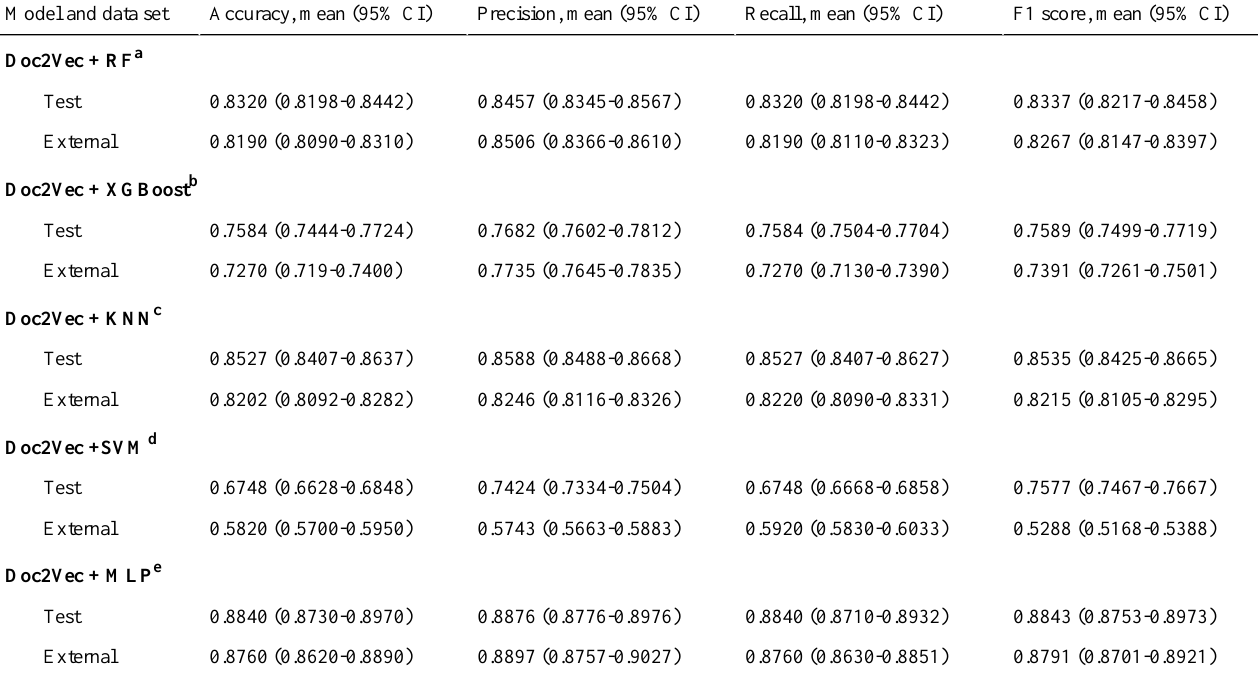
Table 2. Performance analysis of model-based reasoning methods applied for syndrome pattern diagnosis of lung disease based on Doc2Vec in the test and external data